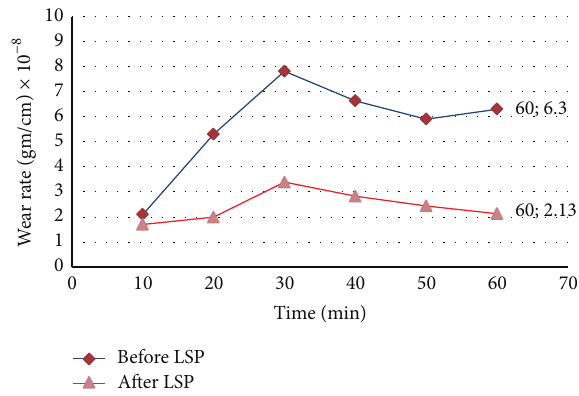
Figure 9: Variation of wear rate of 2024-T3 before and after LSP treatment with